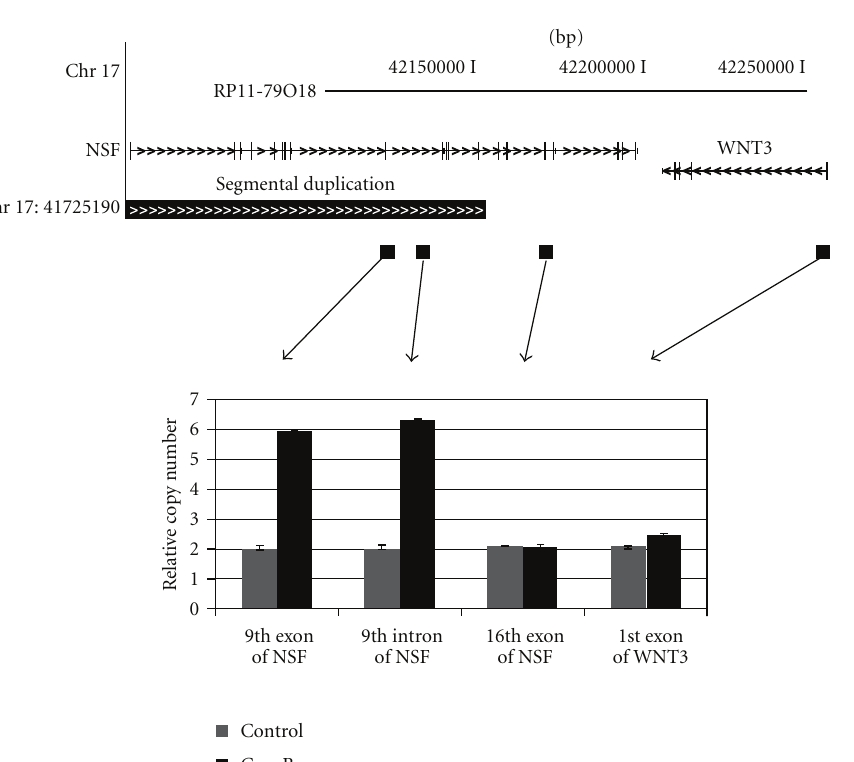
Figure 4: Characterization of a gain-type CNV detected on a BAC-clone RP11-79O18. A genome map of the RP11-79O18-containing region was obtained from the UCSC Genome Browser website. The distance (bp) from the p-terminal of chromosome 17 is shown in the uppermost part. That region contains two genes, that is, N-ethylmaleimide-sensitive factor ( NSF ) and wingless-type MMTV integration site family, member 3 ( WNT3 ). The positions of PCR primers examined are shown by the solid boxes. The experimental conditions are described more precisely in the text. The individual (Case B) has variant fragments with gain type. For the individual showing a CNV, a part of region of the gene NSF was amplified ( × 3). However, no copy number change was observed in the region of WNT3 .